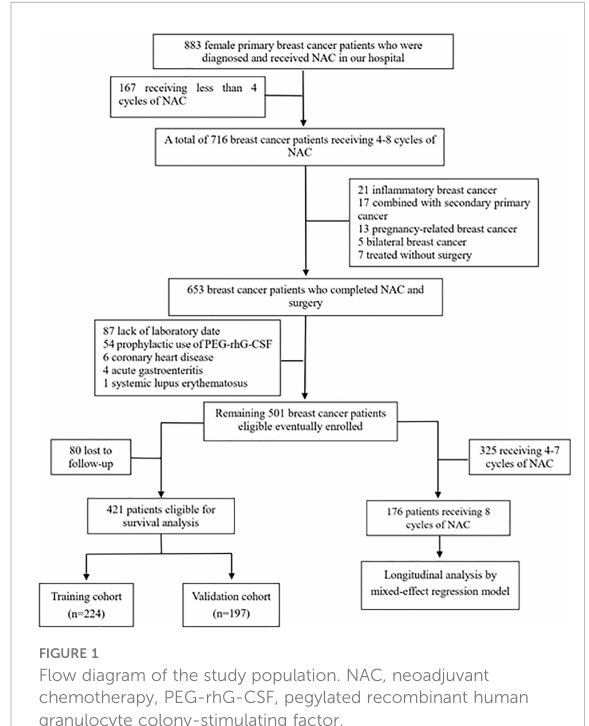
FIGURE 1 Flow diagram of the study population. NAC, neoadjuvant chemotherapy, PEG-rhG-CSF, pegylated recombinant human granulocyte colony-stimulating